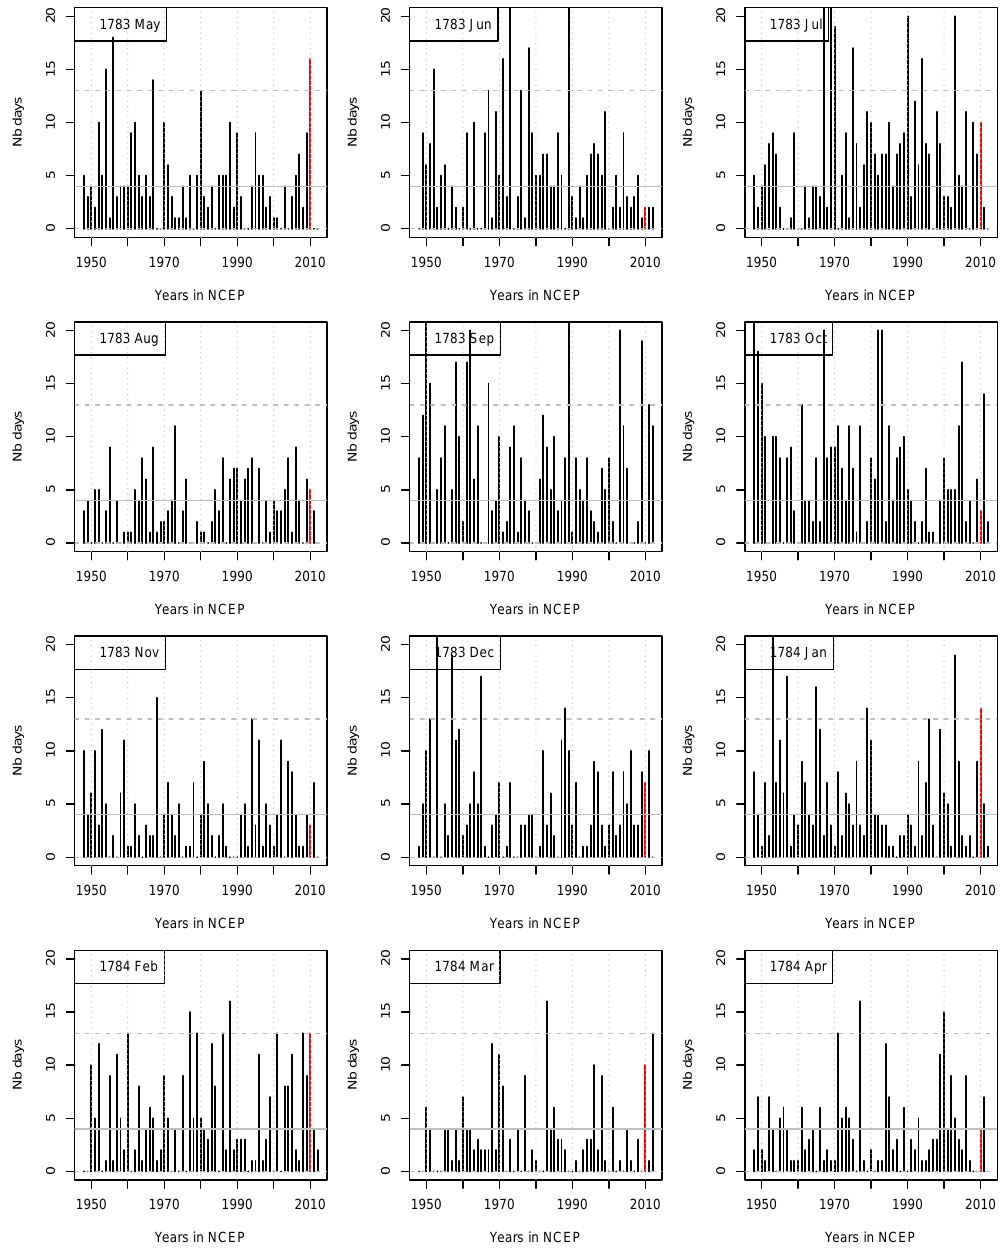
Fig. 3. Histograms of years of the 20 first analogues (between 1948 and 2012), for the months between May 1783 and April 1784. The 2010 year is outlined in red. The horizontal grey lines represent the median frequency of the years of analogues. The horizontal dashed lines are the 10th and 90th quantiles of the frequency of the years of